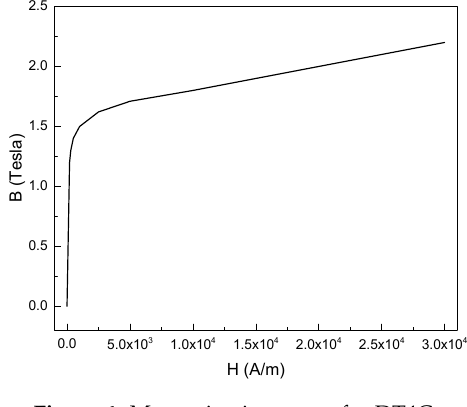
0.0 Figure 4. Magnetization curve for DT4C. Figure 4. Magnetization curve for DT4C. Figure 4. Magnetization curve for DT4C. Figure 4. Magnetization curve for DT4C. Figure 4. Magnetization curve for DT4C.